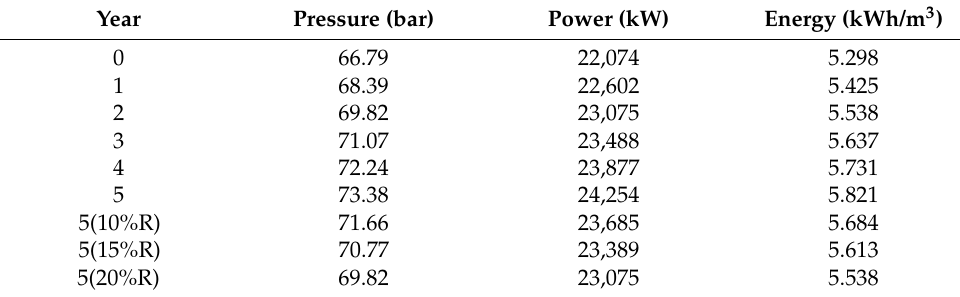
Table 1. Pressure, Power, and Energy consumption at 22 ◦ C.